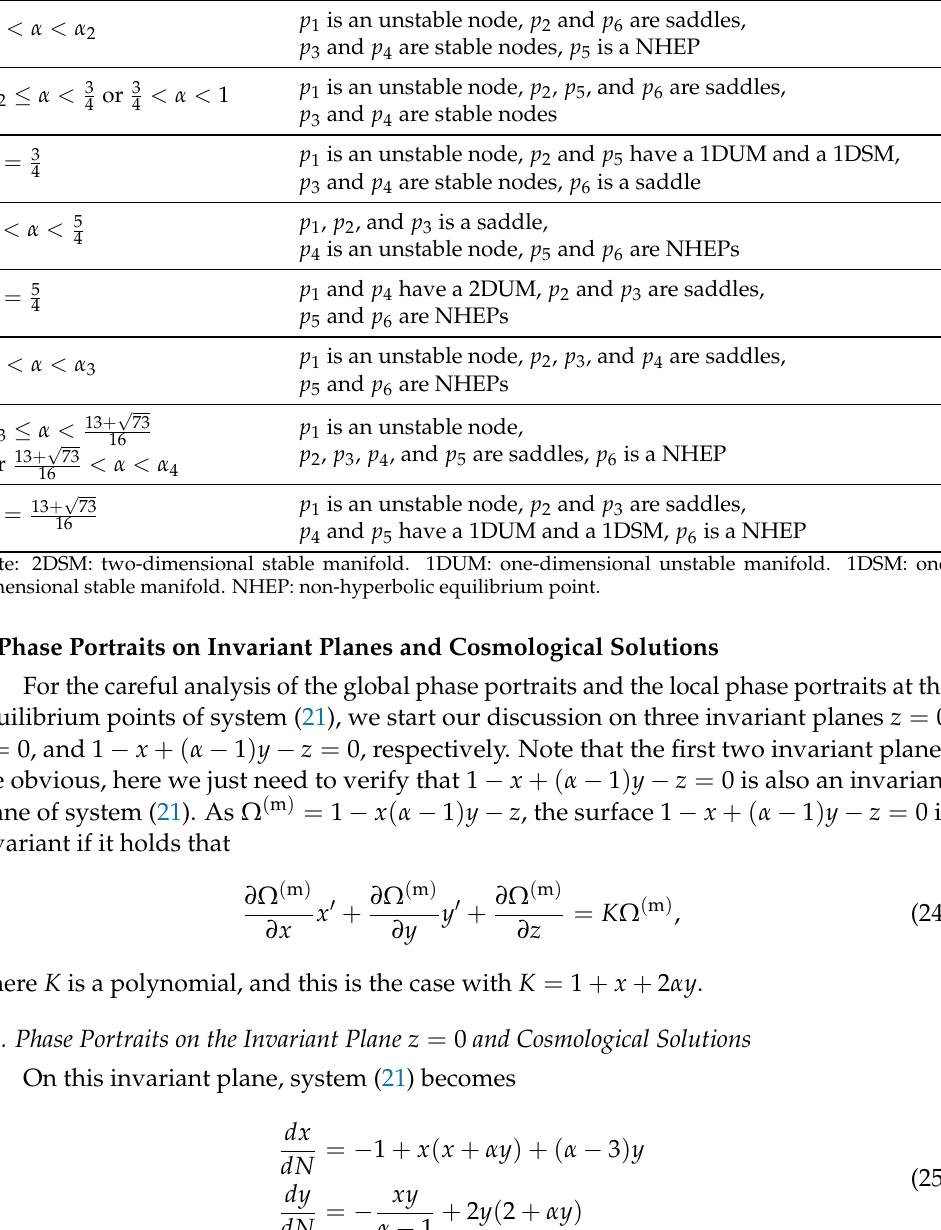
Table 2. Cont. Values of